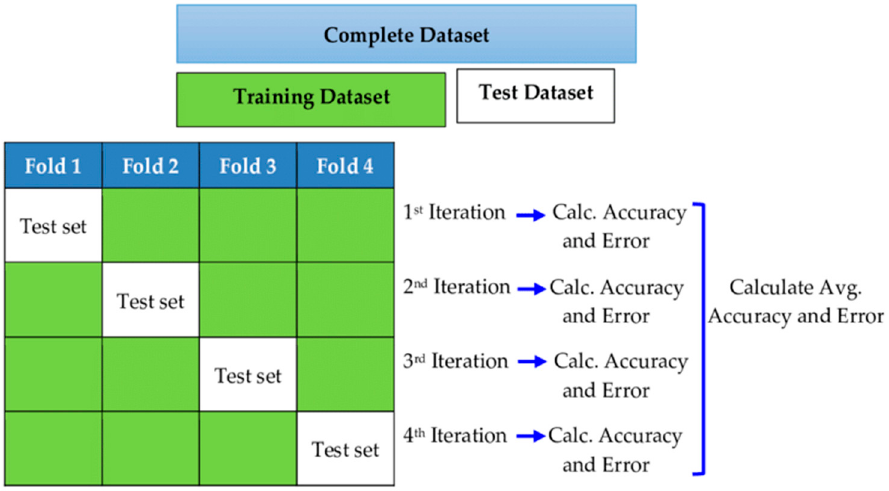
Figure 8. Cross-validation layout for evaluation of the ML algorithms based on 4 k folds. Table 6. Cross-validation for the ML models for estimating SPI at 3, 6, 9, and 12 months.